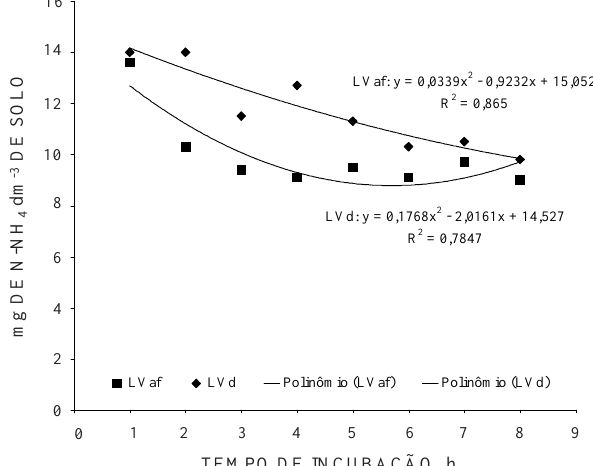
TEMPO DE INCUBAÇÃO, h Figura 2. Efeito do tempo de incubação sobre a velocidade de hidrólise da uréia (mg de N- HH dm -3 de solo), em amostras de Latossolo 4 Vermelho Aluminoférrico típico e Latossolo Vermelho distrófico típico.